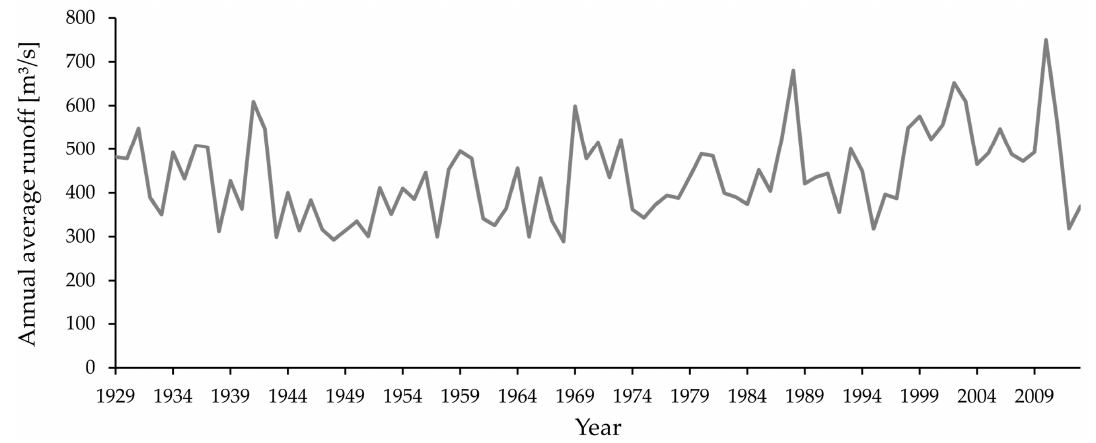
Figure 2. Annual average runoff of the Ili River at hydrostation in Dobyn (m 3 /s) [30].